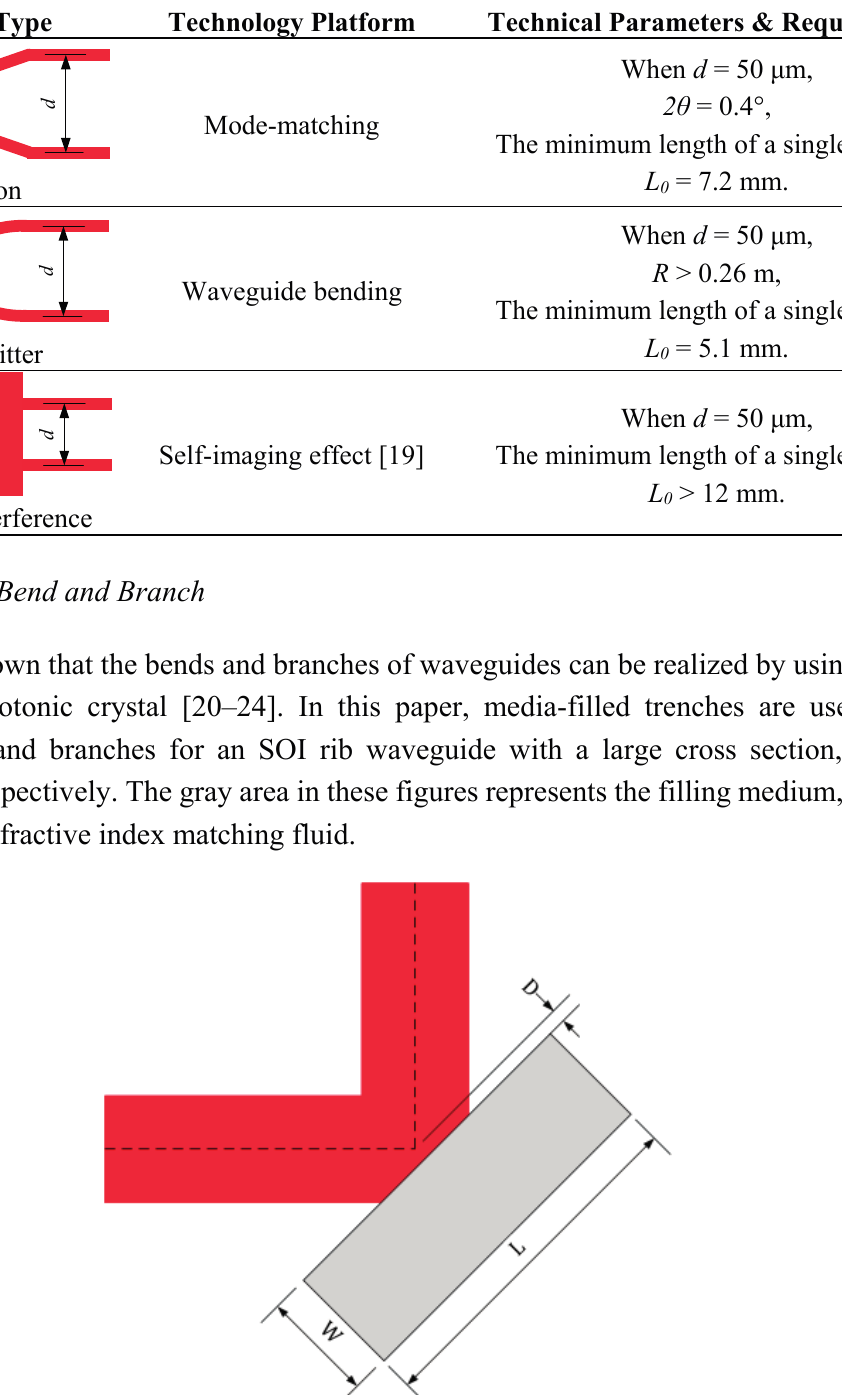
Table 1. The conventional implementations of waveguide branches for SOI rib waveguide